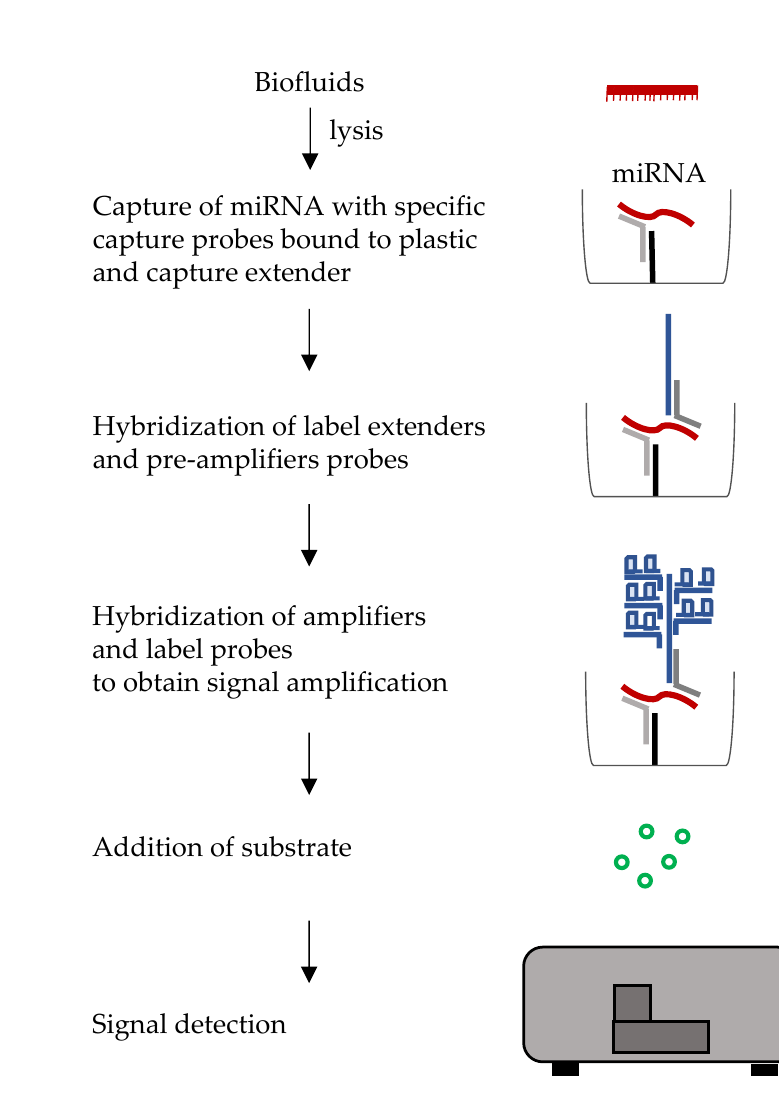
Figure 9. Diagram of standard branched DNA workflow. A cascade of hybridization steps, using different types of probes, leads to signal